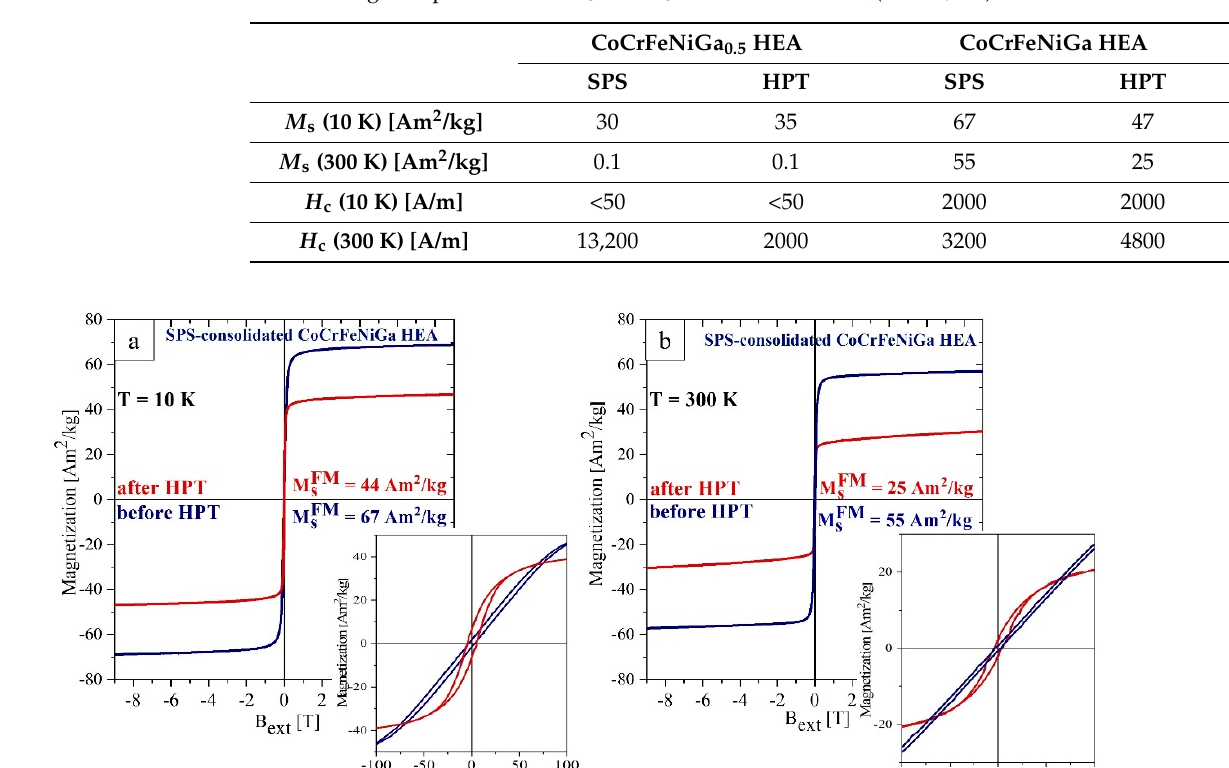
Figure 10. Field dependence of magnetization at 10 K ( a ) and 300 K ( b ) for SPS-consolidated (blue) and after HPT treatment (red) CoCrFeNiGa. Inserts show the low-field region of the M(H) curves. Table 3. Magnetic parameters— M s and H c —for CoCrFeNiGa x (x = 0.5, 1.0).